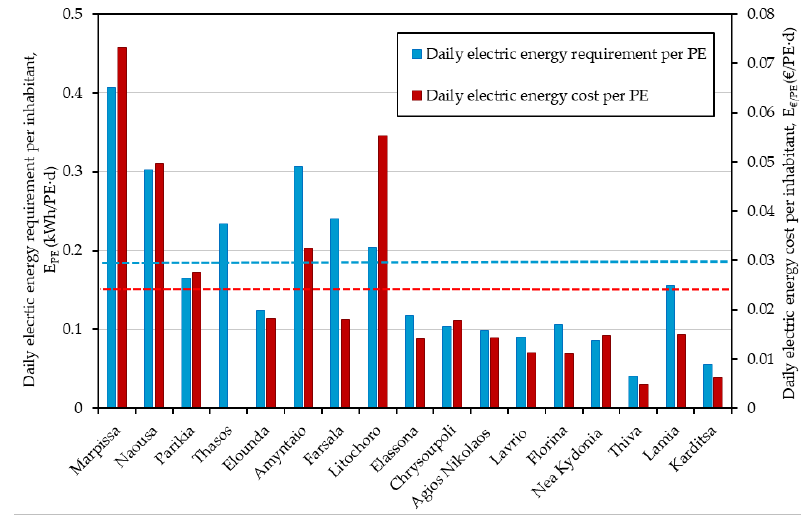
Figure 4. Blue bars and dashed line: daily electric energy requirements per inhabitant, E PE (kWh / PE · d) and average value, respectively; red bars and dashed line: daily electric energy cost per inhabitant, E € / PE ( € / PE · d), and average value, respectively (Thasos WWTP is not included due to lack of